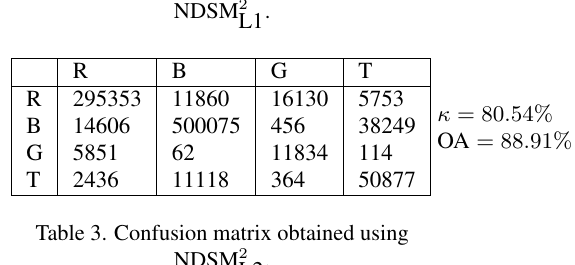
Table 2. Confusion matrix obtained using